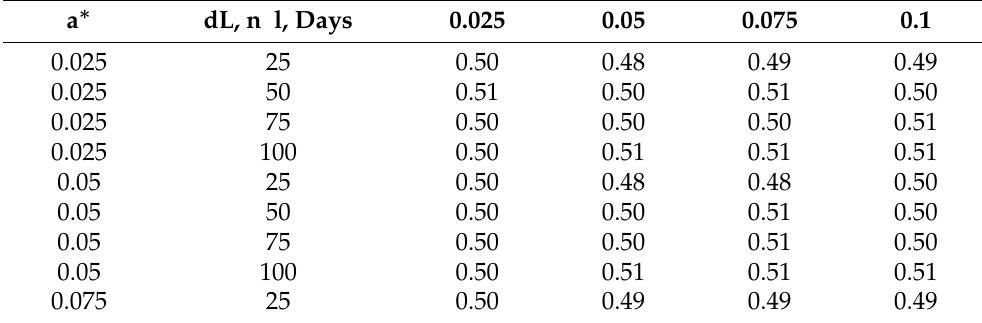
Table 5. Trend confirmation frequency for different parameter values.